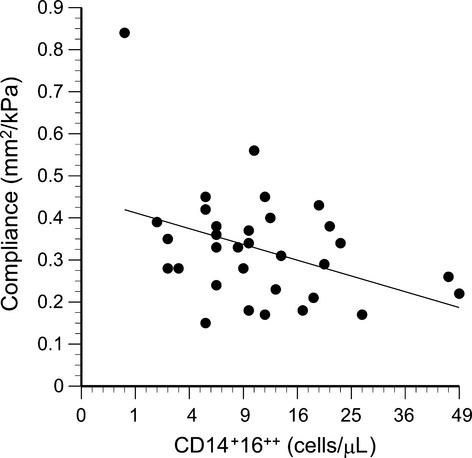
Carotid compliance plotted as a function of the number of circulating CD14+16++ cells (R = −0.39, P = 0.02).